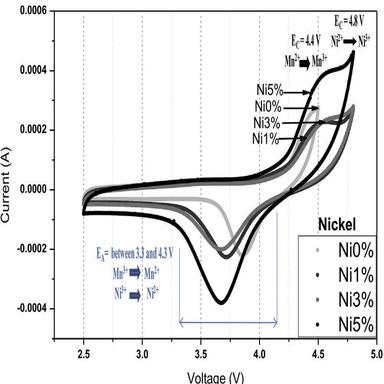
CV curves of all prepared LiMn1-xNixPO4/C cathode materials.